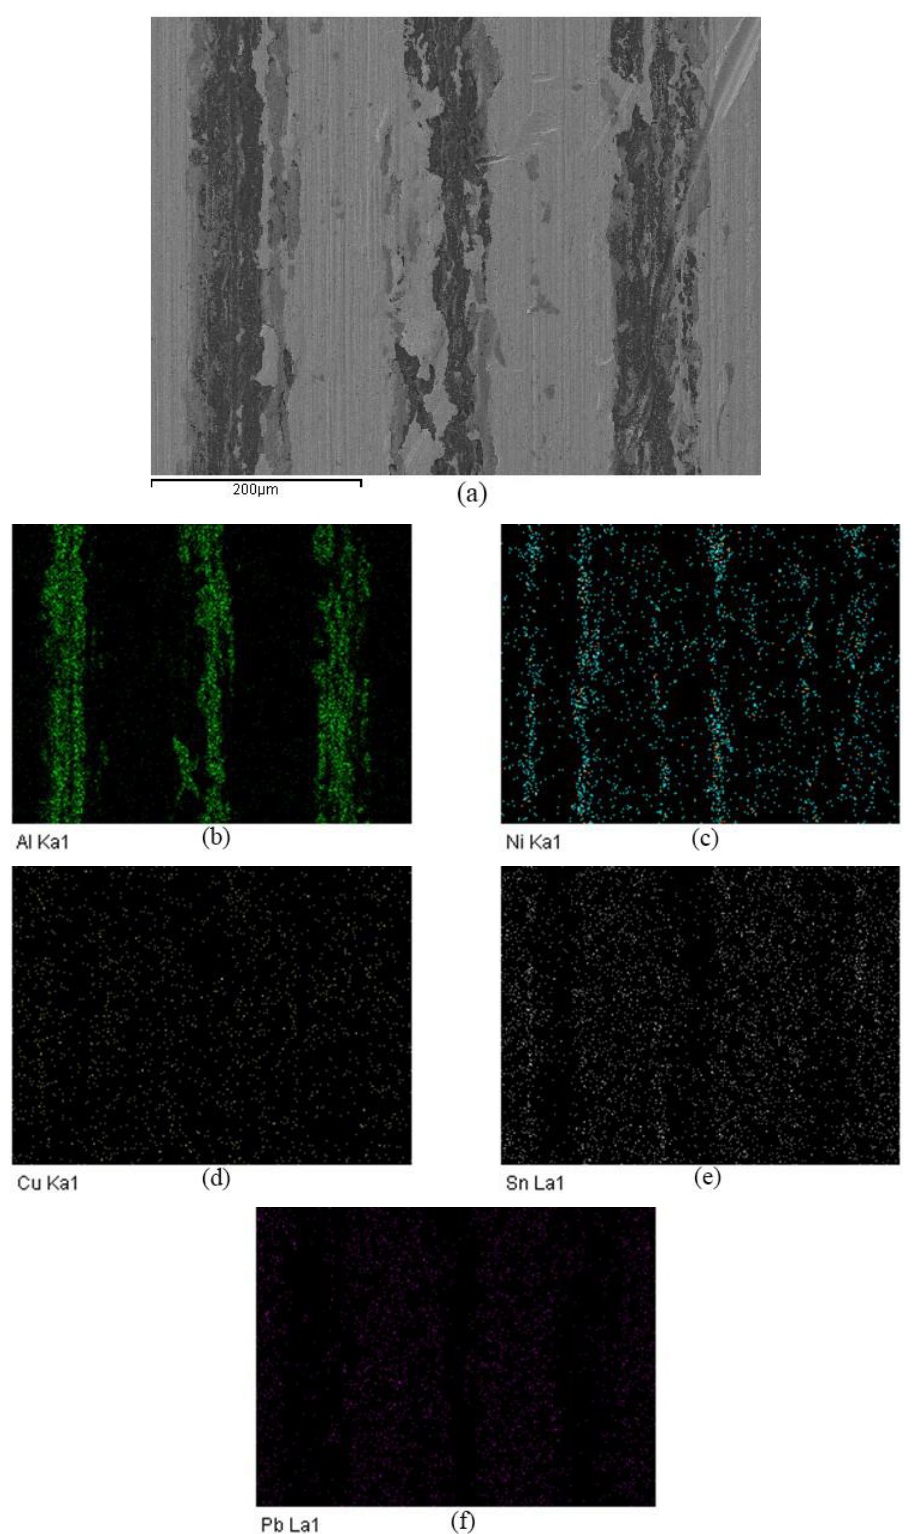
Figure 8. Surface morphology and element distribution of the sliding bearing after wear. ( a ) Surface morphology, ( b ) Al distribution, ( c ) Ni distribution, ( d ) Cu distribution, ( e ) Sn distribution, and ( f ) Pb distribution.